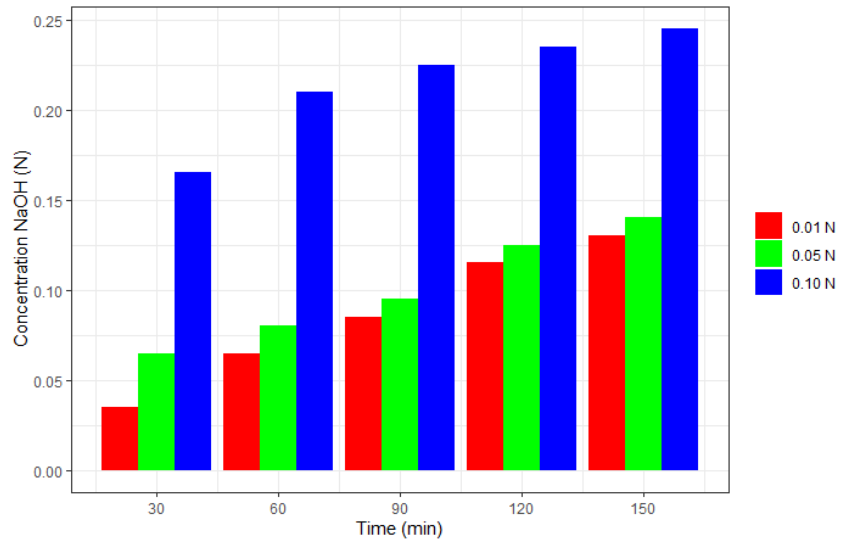
Figure 4. Effect of NaOH Concentration at 6.5 V and 35 ◦